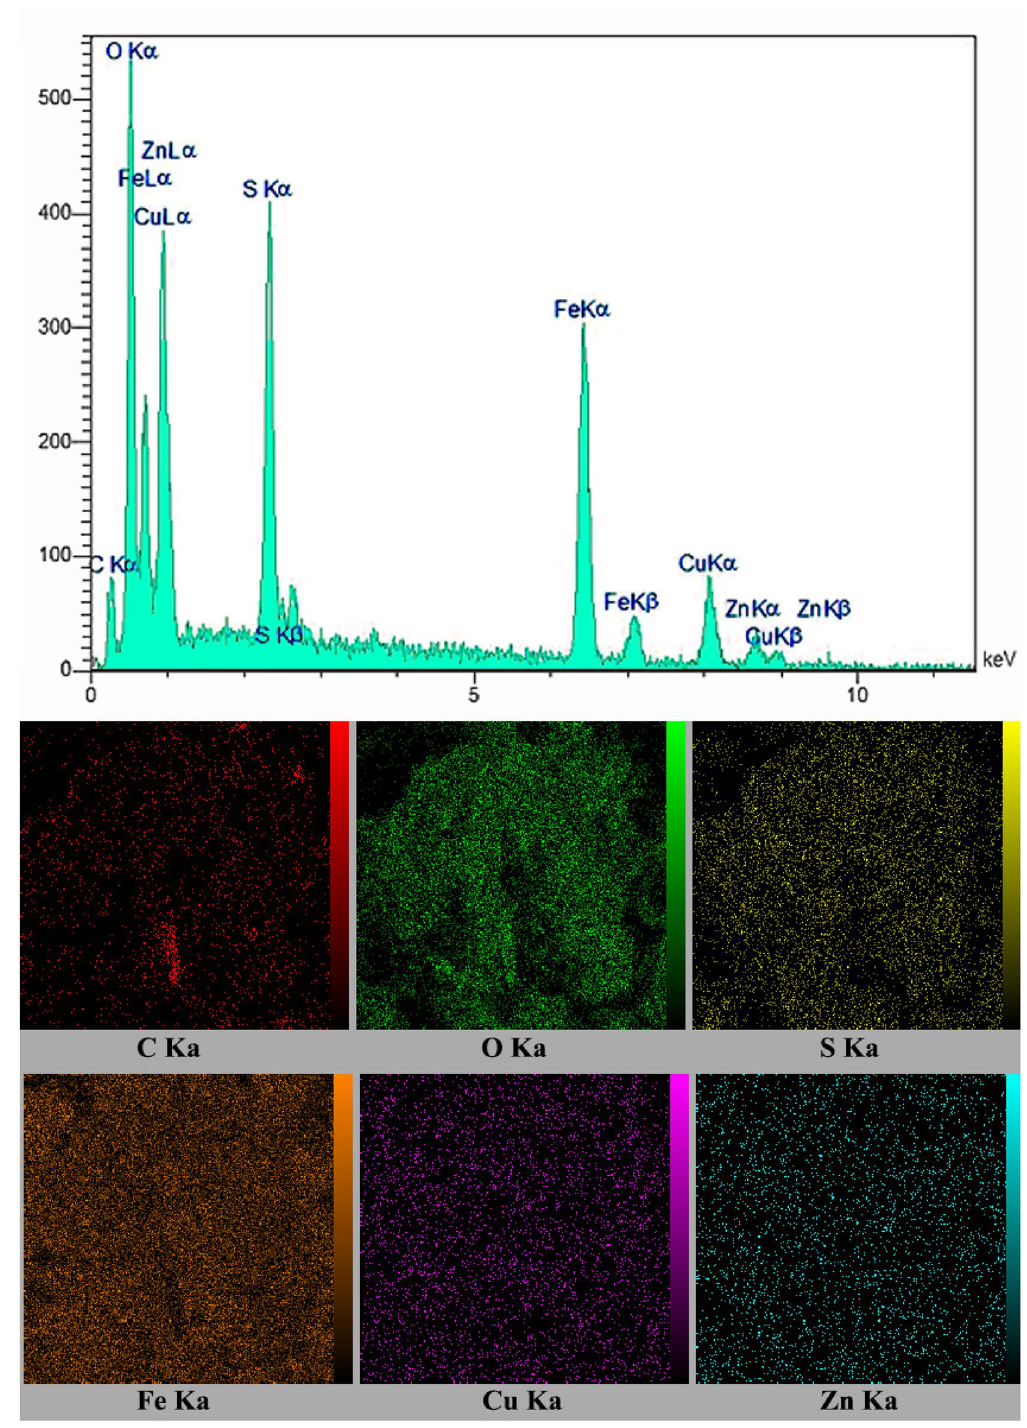
Figure 3. EDX spectra and elemental mapping image of of the agar supported ZnS/CuFe 2 O 4